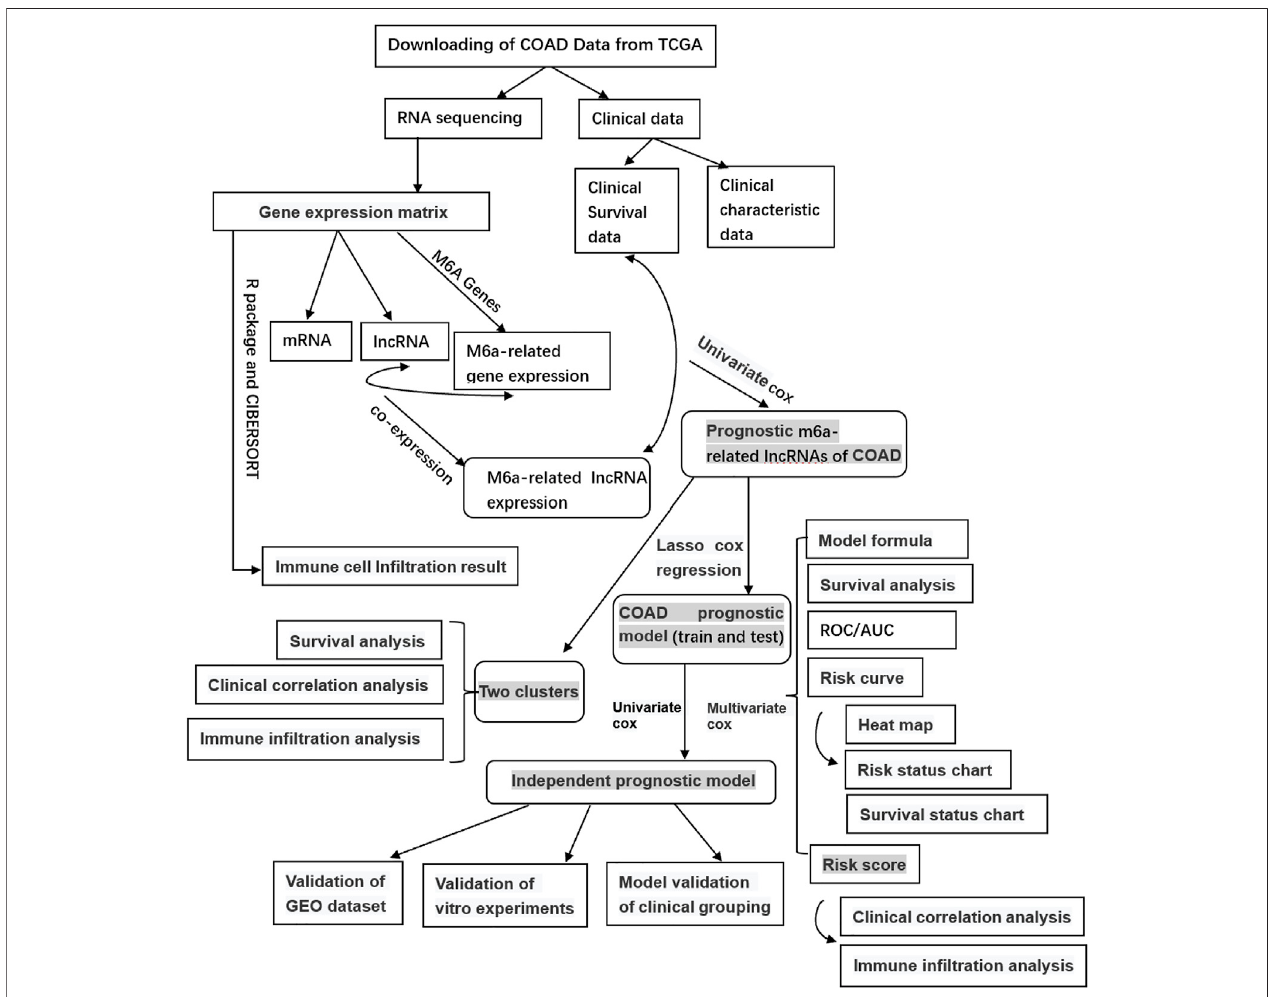
FIGURE 1 | Study fl ow chart of the integration